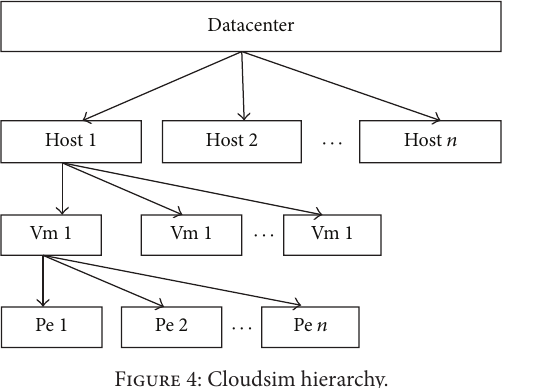
Figure 4: Cloudsim hierarchy.